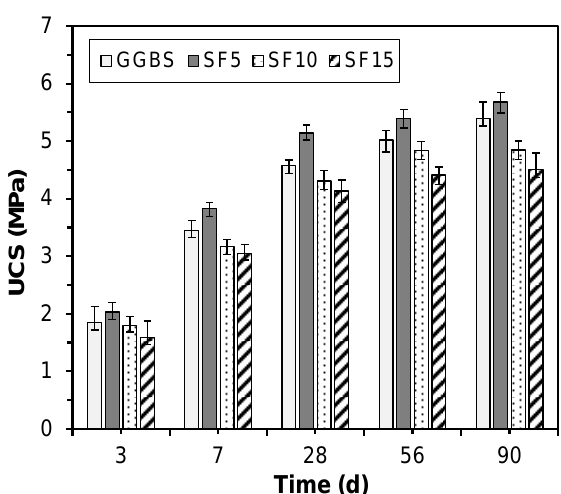
Figure 12. SF ’s effect on CPB’s strength properties . Figure 12. SF’s effect on CPB’s strength properties.